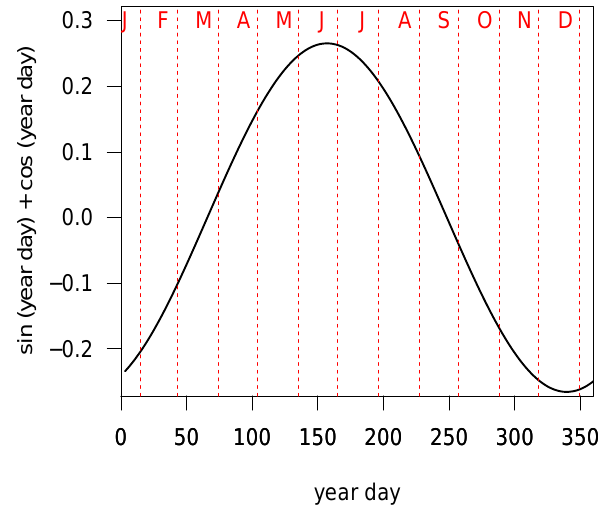
Fig. 6. The sum of sine and cosine model coefficients multiplied by year day highlighting the seasonal effect of temperature on headwa- ter stream p CO 2 . Differences in the magnitude of the coefficients used to apply the model at the midpoint of each calendar month (J=January, F=February, etc.) are highlighted by the dashed red